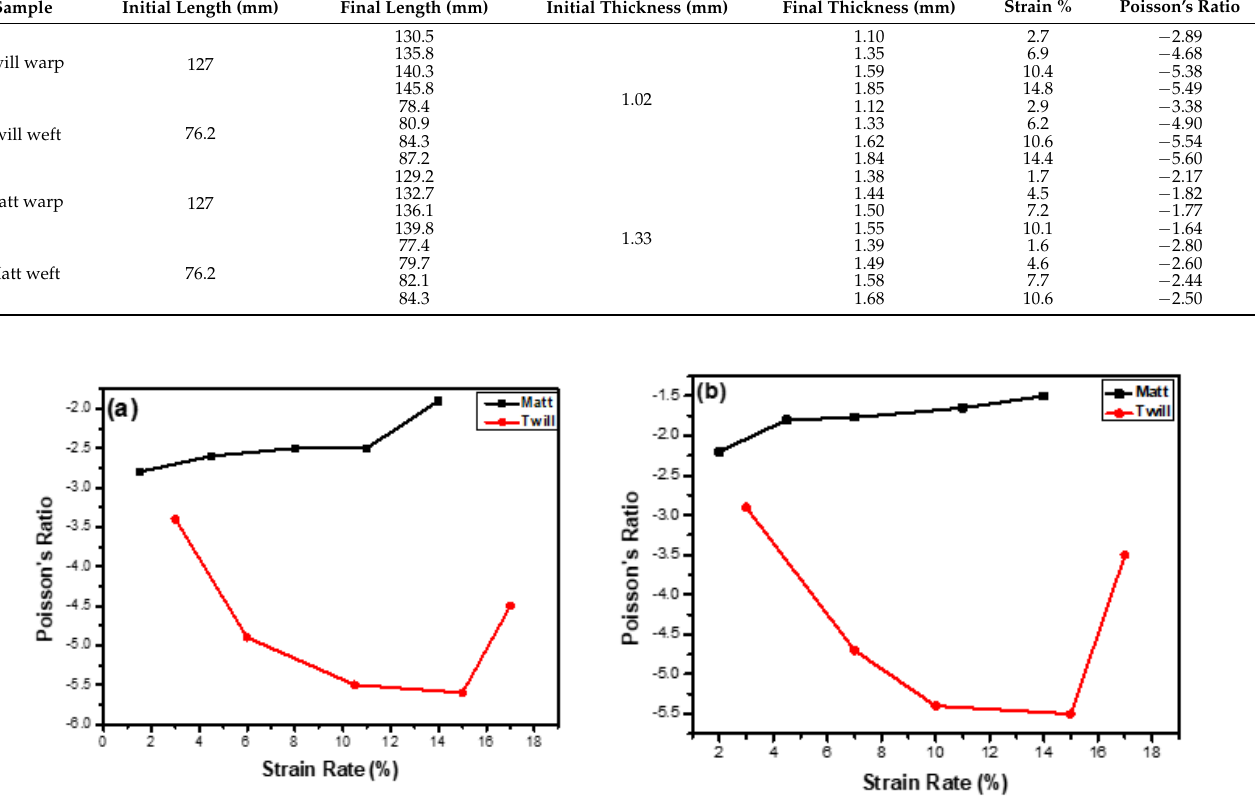
Figure 11. Graph between Poisson’ Ratio and Strain percent for twill and matt fabrics ( a ) Warp wise, and ( b ) Weft wise.